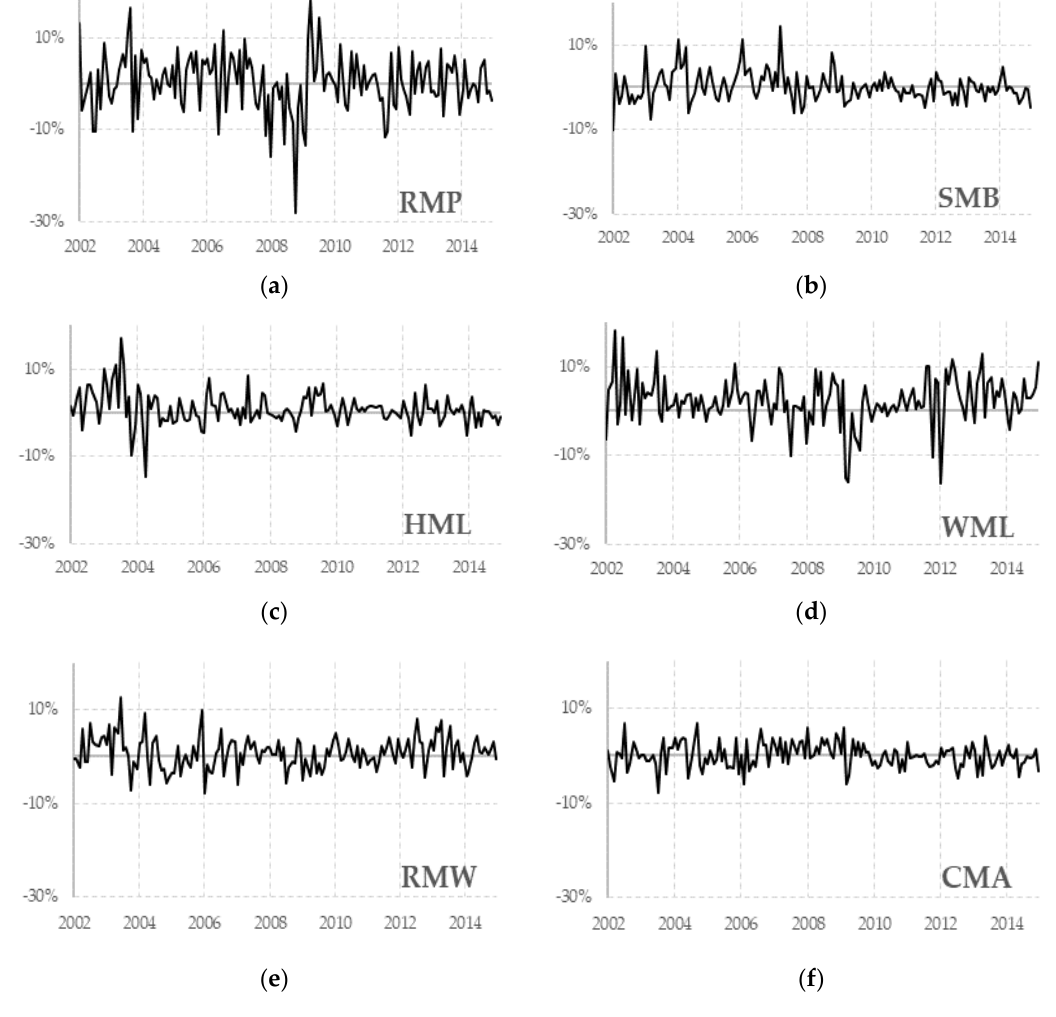
Figure 2. Risk premiums.